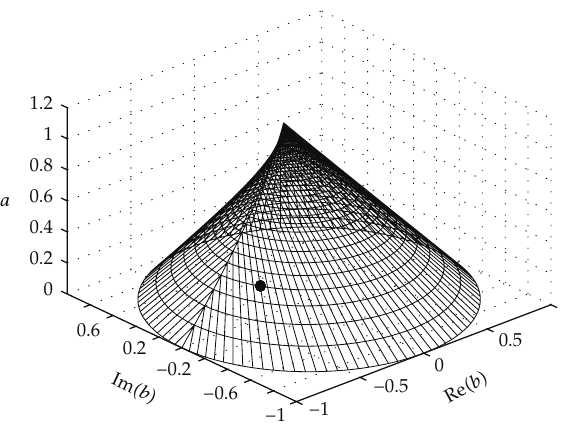
Figure 4: Stability cone for k (cid:3) 6. The point on the cone is constructed for Example